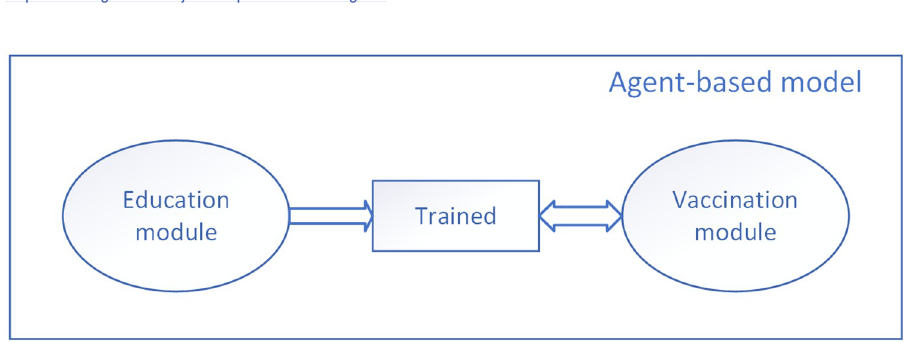
Fig 5. The structure of the model of micro level based on the activity of HCWs. The education module and the vaccination module are concentrated by the state “Trained” which is described both in the two modules. The arrows demonstrate the available state transition